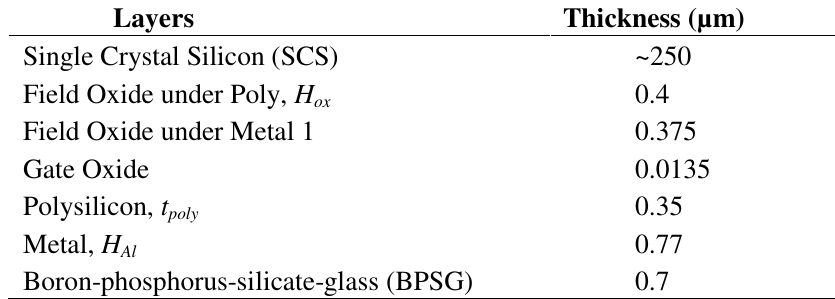
Table 1. Typical CMOS Layers Thickness in the ON 0.5 µm Technology